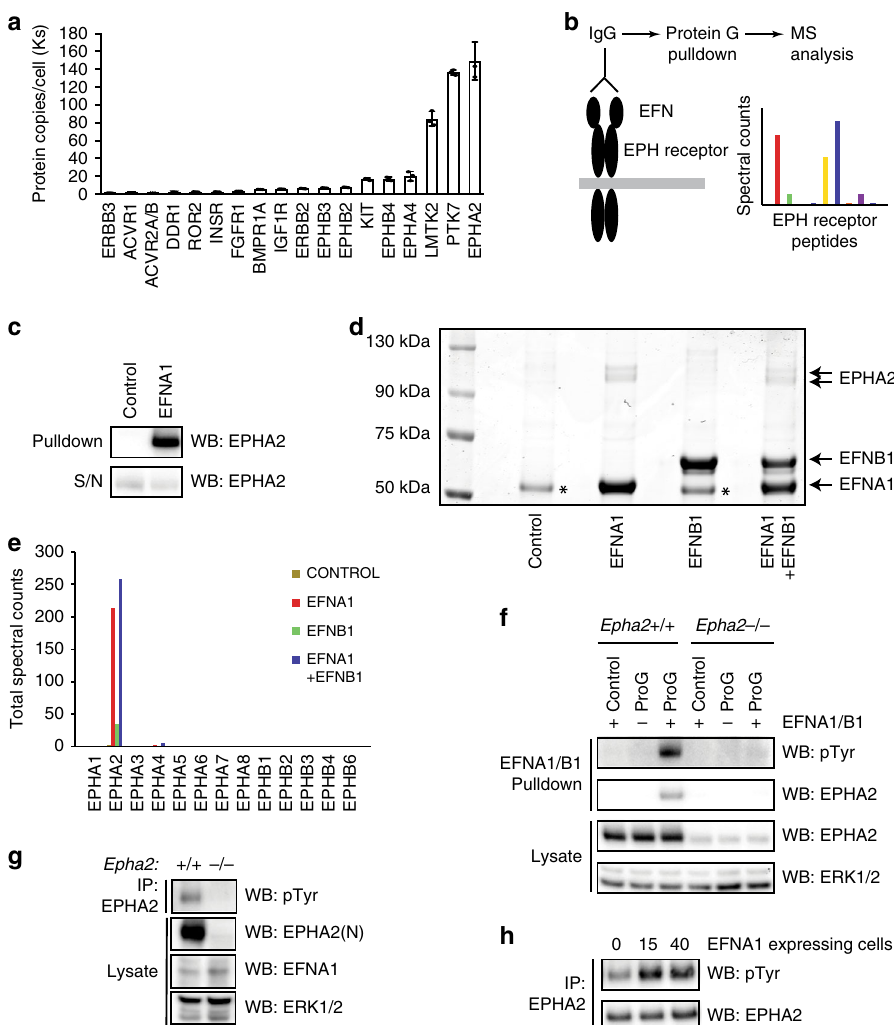
Fig. 2 EPHA2 is critical for EFN ligand responses in mESCs. a Average protein copy number per cell determined for receptor kinases in mESCs, using quantitative whole-cell proteomics. Data are presented as mean ± SD ( n = 3). b Work fl ow for quanti fi cation of EPH – EFN interactions in mESCs by EFN ligand af fi nity puri fi cation mass spectrometry. c Proof-of-principle identi fi cation of EPH – EFN interactions by EFN ligand af fi nity puri fi cation. EPHA2 levels were determined by immunoblotting. d Coomassie staining of EFNA1/B1 af fi nity puri fi cation from mESCs. EFNA1, EFNB1 and EPHA2 proteins are indicated. (*) = non-speci fi c band. e Mass-spectrometry analysis of 75 – 130-kDa region of the Coomassie stained EFNA1/EFNB1 af fi nity puri fi cation shown in ( d ). Total spectral counts recovered for each EPH receptor family member are indicated. f EFNA1/B1 af fi nity puri fi cation from intact Epha2 + / + and pooled Epha2 − / − mESCs. Phosphotyrosine (pTyr), EPHA2 and ERK1/2 levels were determined by immunoblotting. Note that the pTyr signal is speci fi c for EPHA2, and is not detected in the absence of EFN ligand. g EPHA2 was immunoprecipitated from Epha2 + / + and Epha2 − / − mESCs, and pTyr, EPHA2, EFNA1 and ERK1/2 levels determined by immunoblotting. h Epha2 + / + mESCs were stimulated with EFNA1-expressing Epha2 − / − mESCs for 15 or 40 min. EPHA2 was immunoprecipitated, and pTyr and EPHA2 levels determined by immunoblotting. Source data are provided as a Source Data fi